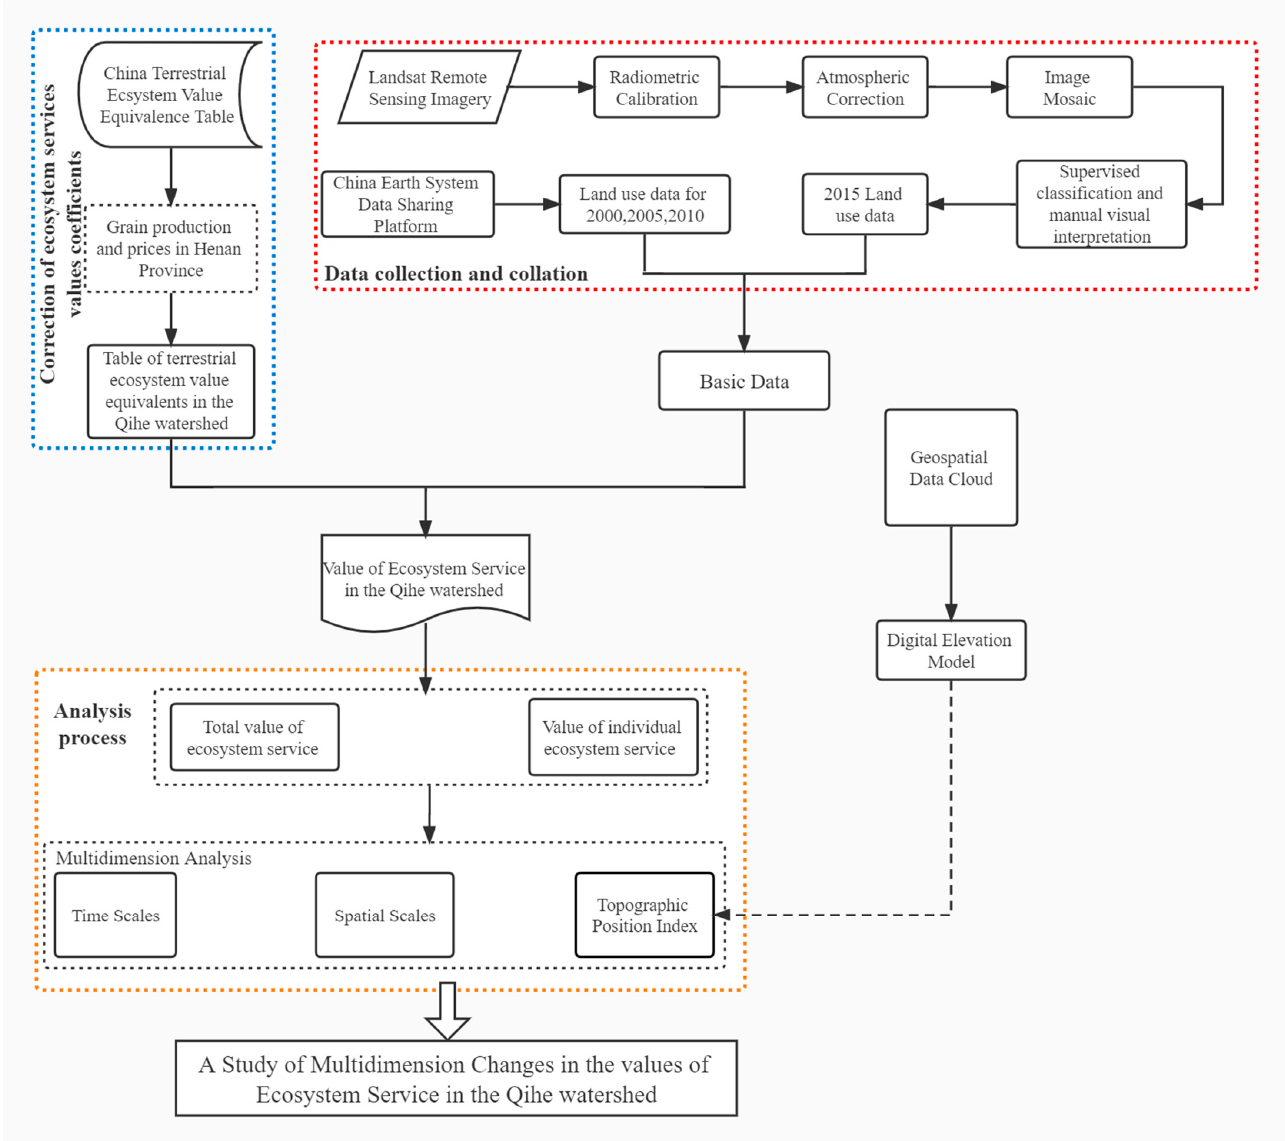
Figure 2. The research framework used for studying multi-dimensional (spatial, temporal, and TPI) changes in the ESV of the Qihe watershed.